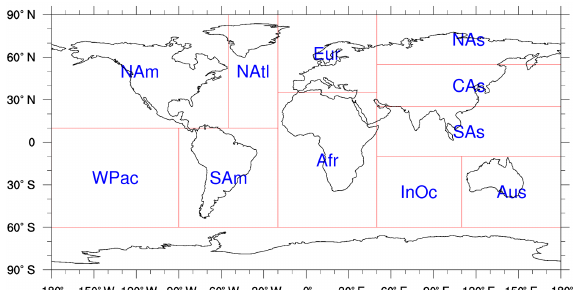
Figure 4. Map of the defined regions used to sort IAGOS CO